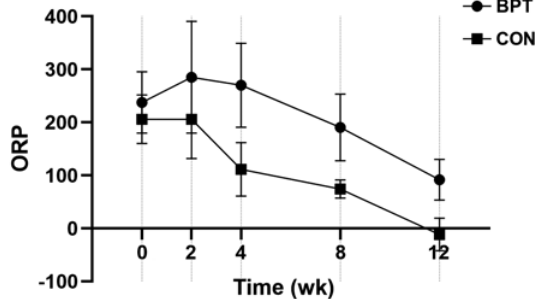
Fig. 1. Dynamic changes of the oxidation−reduction poten- tial (ORP) values during the experimental period. Data are presented as mean ± SD (n = 3). BPT: Bellamya purificata treatment; CON: control